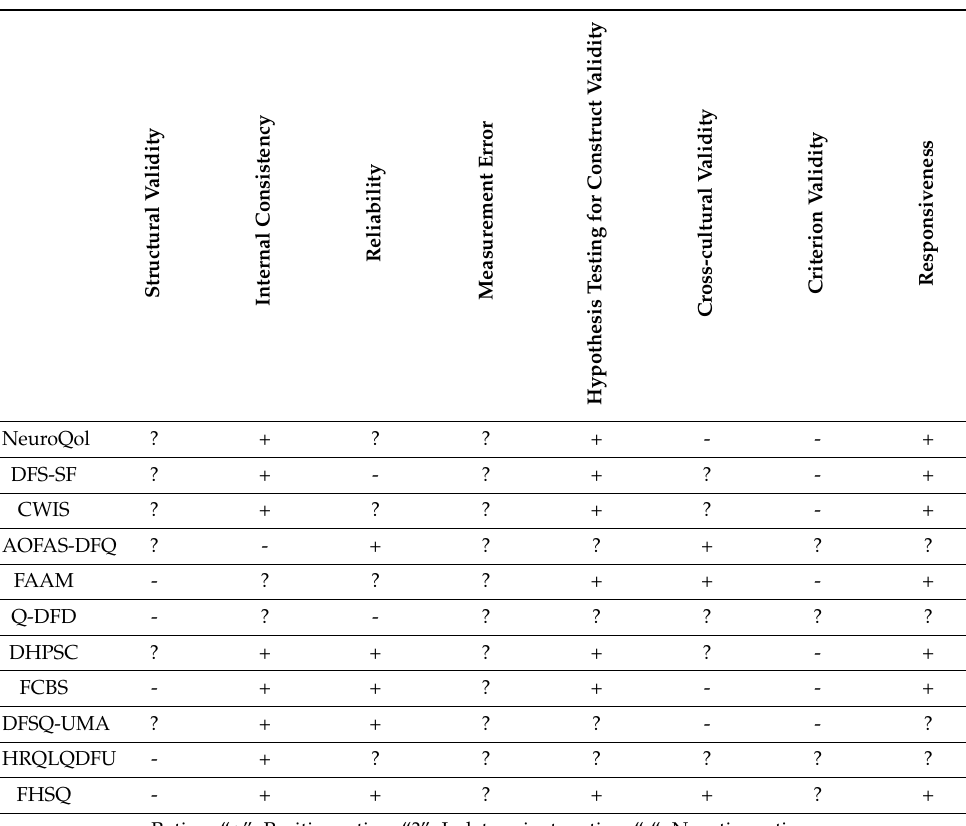
Table 4. Detailed COSMIN